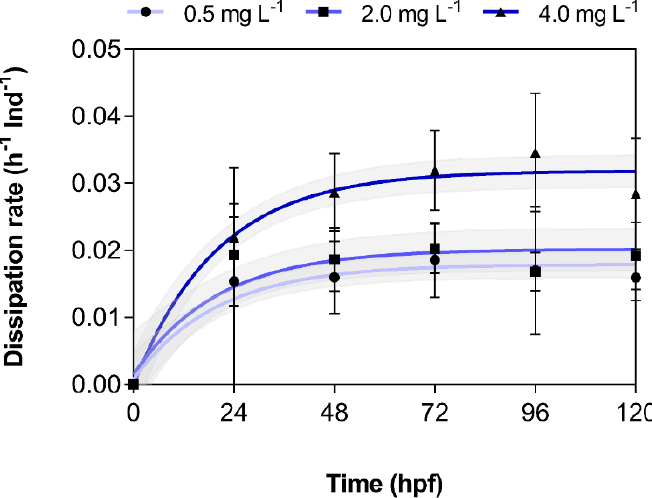
Figure 3. Dependence of the dissipation rates of 3,4-dichloroaniline (3,4-DCA) on exposure concentration and time. Rates were calculated based on the fitted mean and standard error of the one- phase exponential decay data presented in Figure 2 ( n = 2 independent replicates). Shaded area indicates the 95% confidence interval of the regression lines.